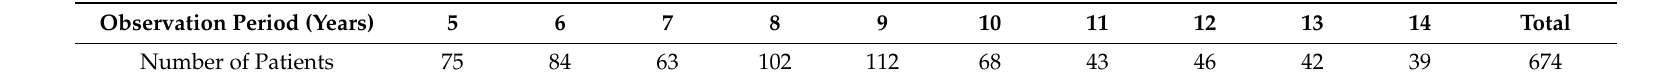
Table 2. Distribution of the observation period.